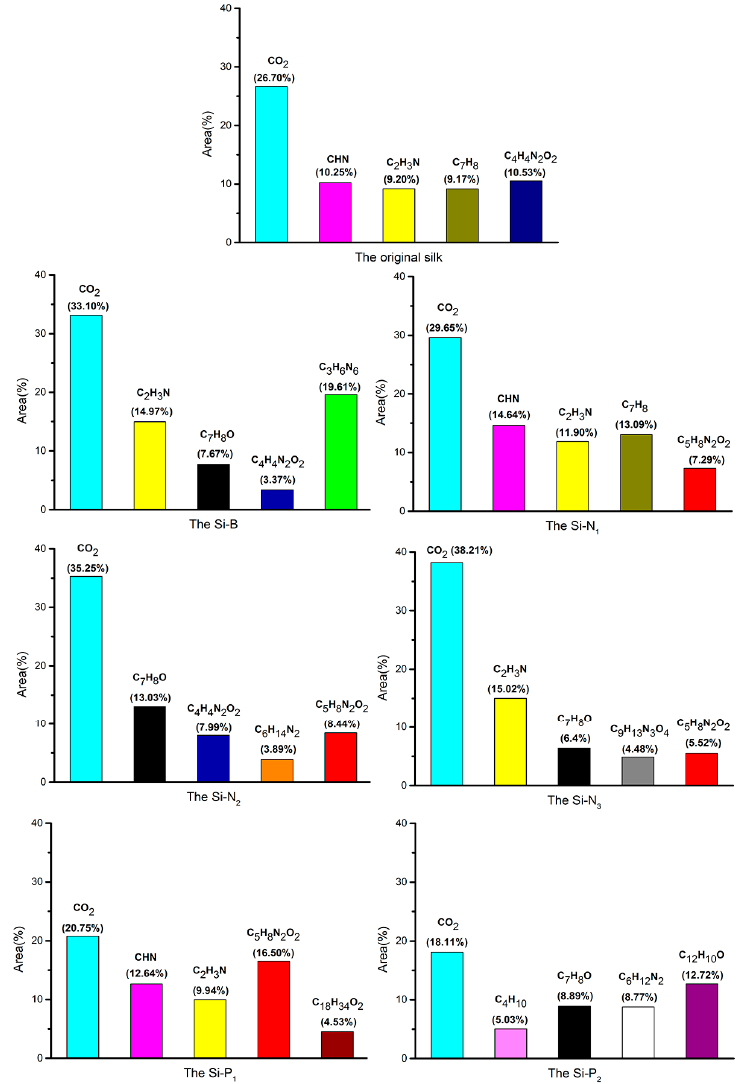
Figure 9. The cleavage productsof original silk and the treated silk